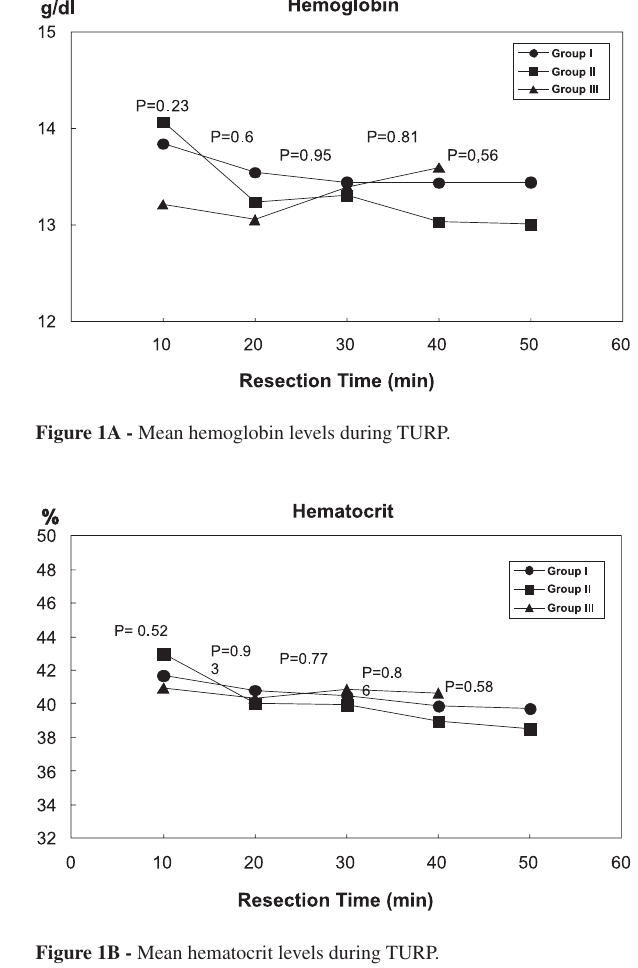
Figure 1B - Mean hematocrit levels during TURP.